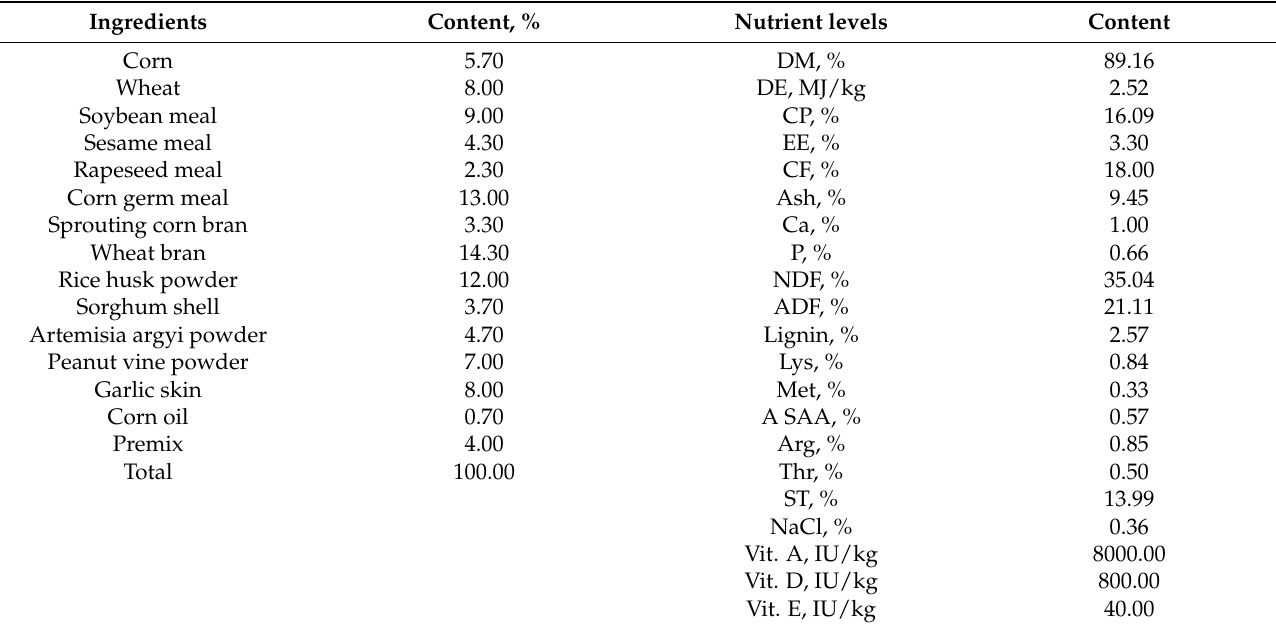
Table 1. Composition and nutrient levels of the basal